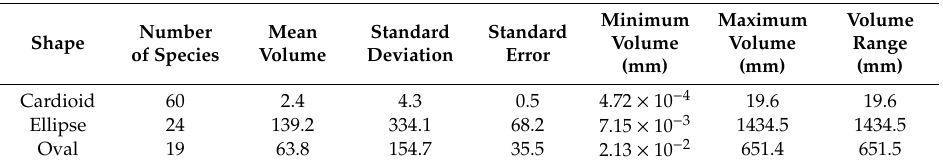
Table 1. Summary of data corresponding to seed volume (mm 3 ) for each of the three geometric models used.